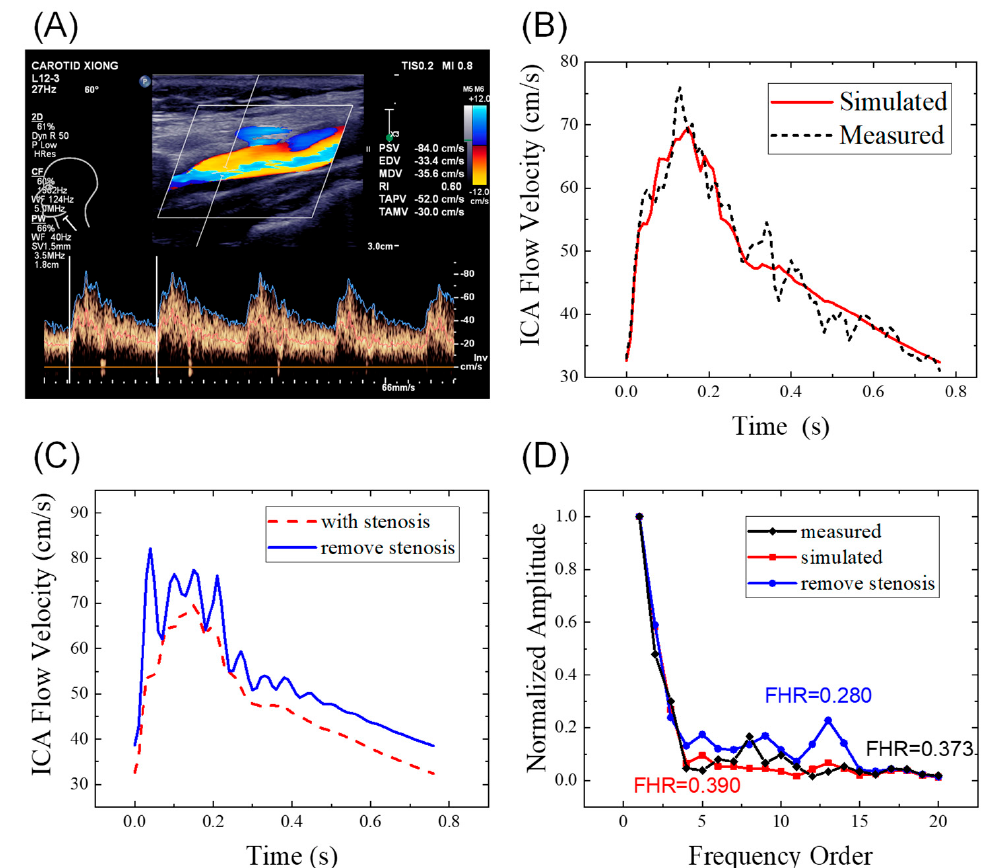
Figure 3. ICA flow waveforms of a patient: ( A ) original Doppler ultrasound data; ( B ) comparison of the measured data and simulated results from the hemodynamic model; ( C ) comparison of the simulated waveforms with and without stenoses; ( D ) comparison in the frequency domain. ICA, internal carotid artery; FHR, first harmonic ratio. The patient ID is 18 in the Supplementary Data.